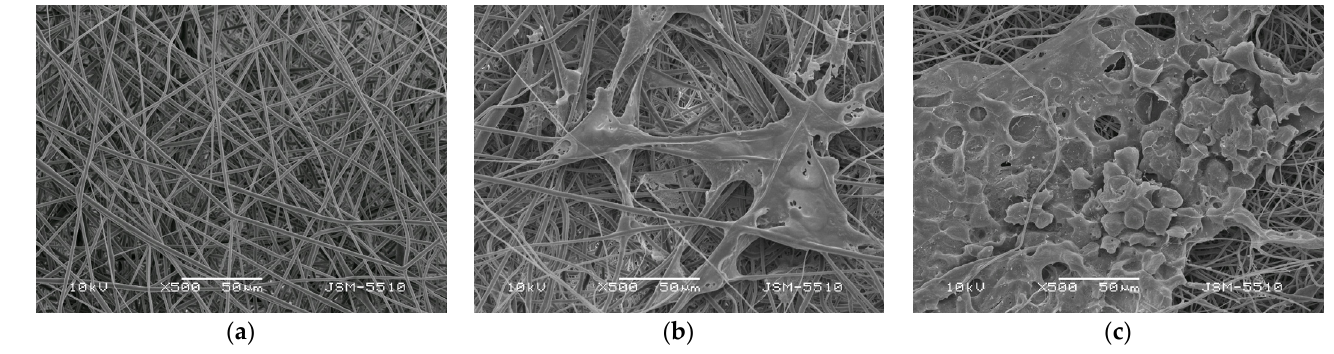
Figure 8. SEM micrographs of: ( a ) PLA fibers; ( b ) mouse fibroblasts on PLA fibers; and ( c ) mouse fibroblasts on PLA/ P. oleracea after 72 h contact.